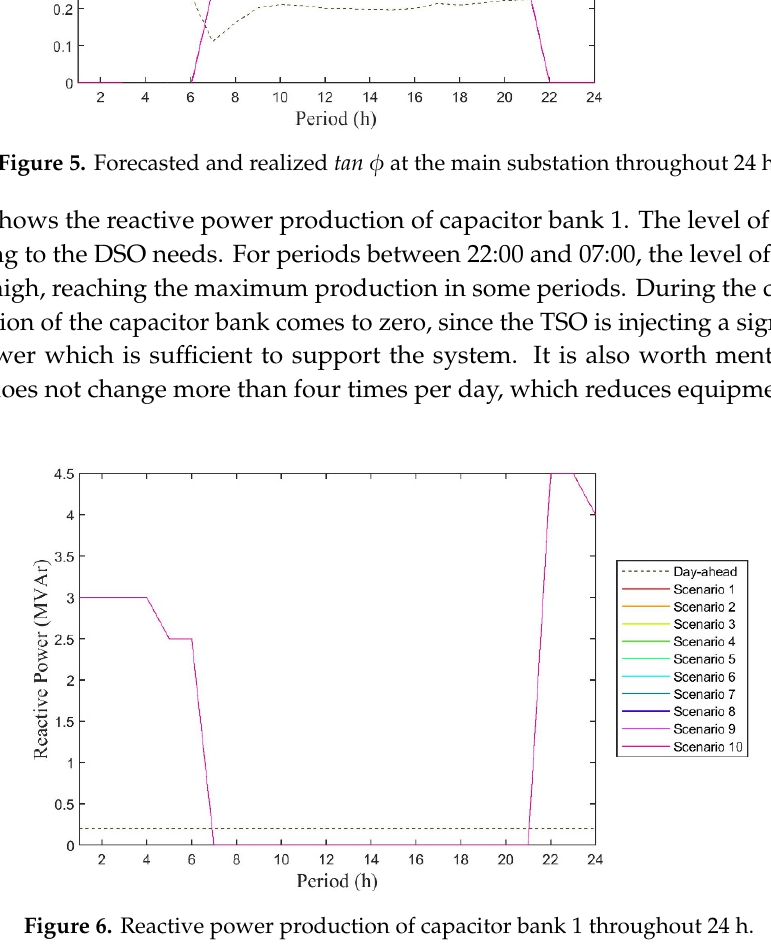
Figure 7. Reactive power production of capacitor bank 2 throughout 24 hours.